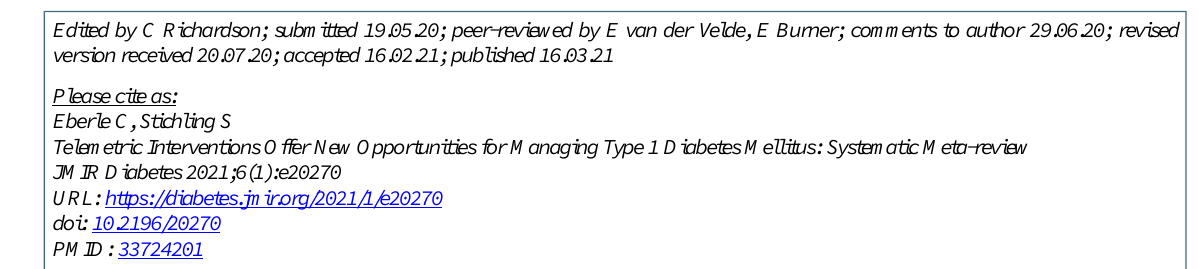
RCT: randomized controlled trial T1DM: type 1 diabetes mellitus T2DM: type 2 diabetes